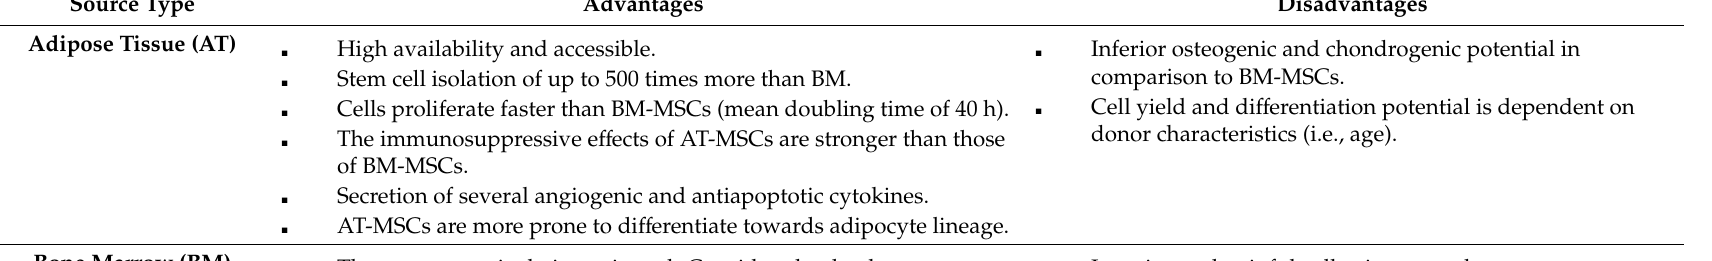
Table 1. Advantages and disadvantages of mesenchymal stromal cells (MSCs) from the three main sources that have been investigated in clinical studies: bone marrow (BM), adipose tissue (AT), and the umbilical cord (UC). Source Type